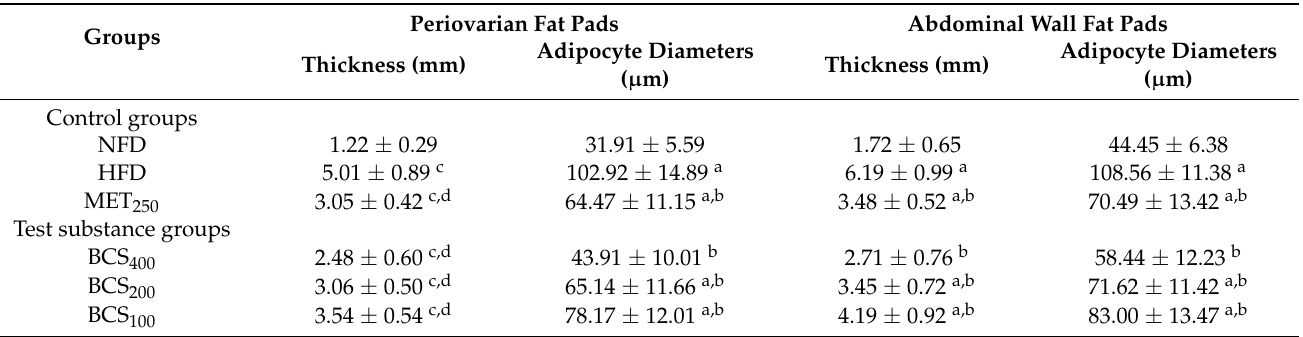
Table 2. Histopathology–histomorphometry of abdominal and periovarian wall accumulated fat pads in HFD- and NFD-supplied groups.